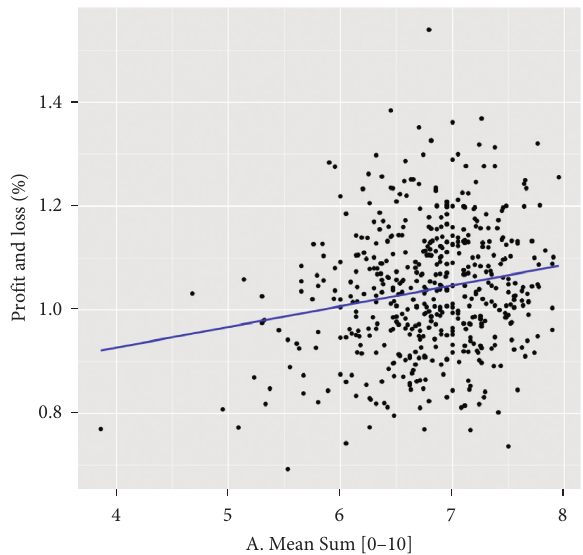
Figure 2: A high correlation between the emotional scores along the arousal dimension of the 26th cluster and its cumulative profits. The solid line represents the prediction within the linear model, and the shaded area represents the 95% confidence regions of the prediction based on the intercept and the given slope.